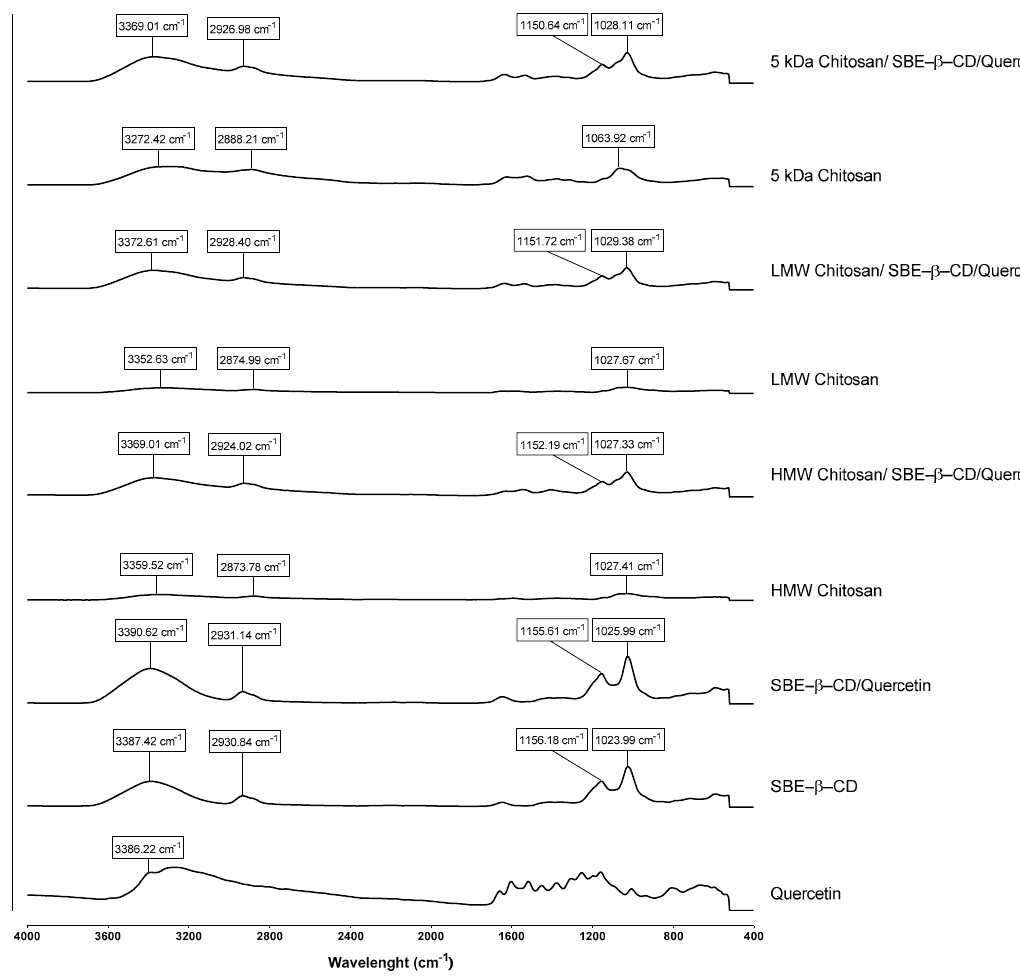
Figure 3. FTIR spectra (absorbance versus wavenumbers) of SBE– β –CD/quercetin inclusion com- plexes, HMW chitosan/SBE- β -CD/quercetin delivery systems, LMW chitosan/SBE– β –CD/quercetin delivery systems and 5 kDa chitosan/SBE– β –CD/quercetin delivery systems.